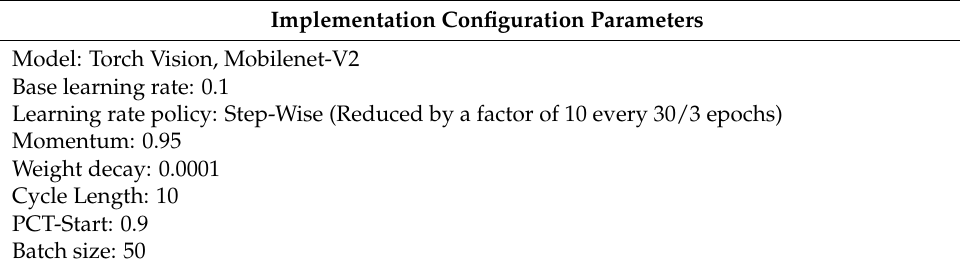
Table 2. The configuration information of the proposed